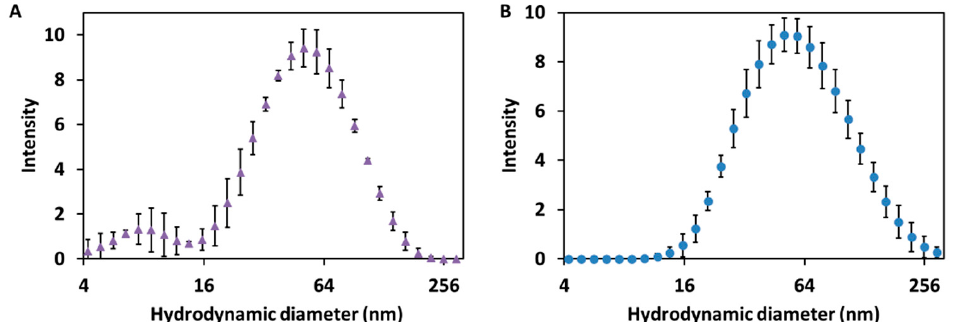
Figure 3. DLS analysis of the hydrodynamic diameters of Cur-AgNPs. ( A ) before dialysis and ( B ) after dialysis. The x axis representing the particle size is presented in logarithmic scale.